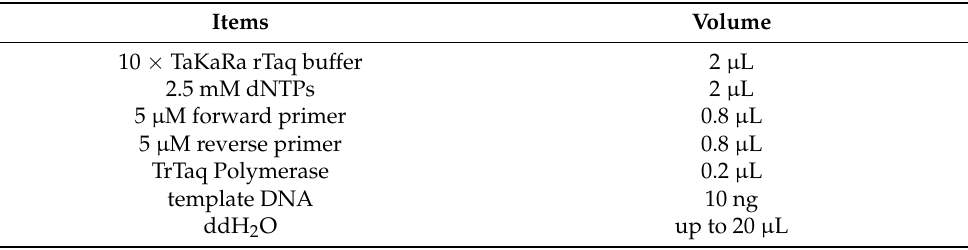
Table 1. The reaction system for PCR amplification. Items